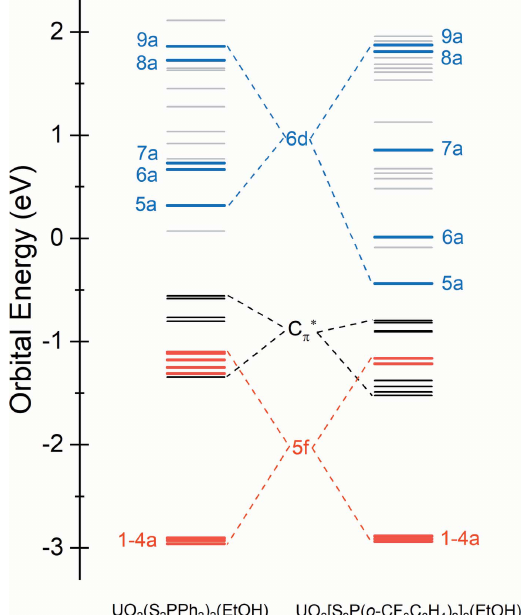
Figure 5 The truncated orbitals energy levels for UO 2 (S 2 P R 2 ) 2 (EtOH) calculated at the B3LYP/TZ2P level. The red and blue lines denote the orbitals containing primarily U 5 f and 6 d character,